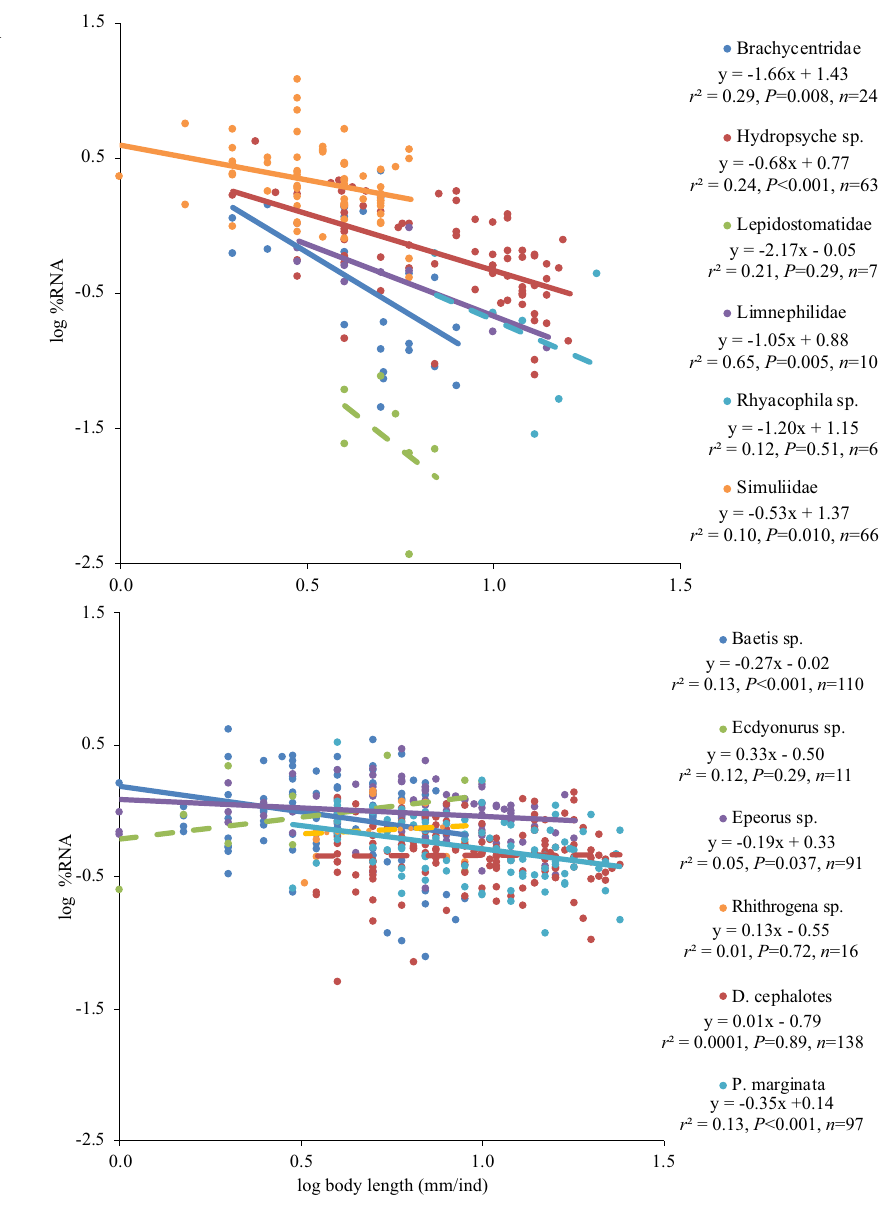
Figure 2. Relationship between body length and %RNA for ( A ) holometabolous and ( B ) hemimetabolous taxa in this study. Equations and regression parameters for linear regressions are included to the side of the figures. Solid lines indicate significant fits, and dashed lines nonsignificant fits.